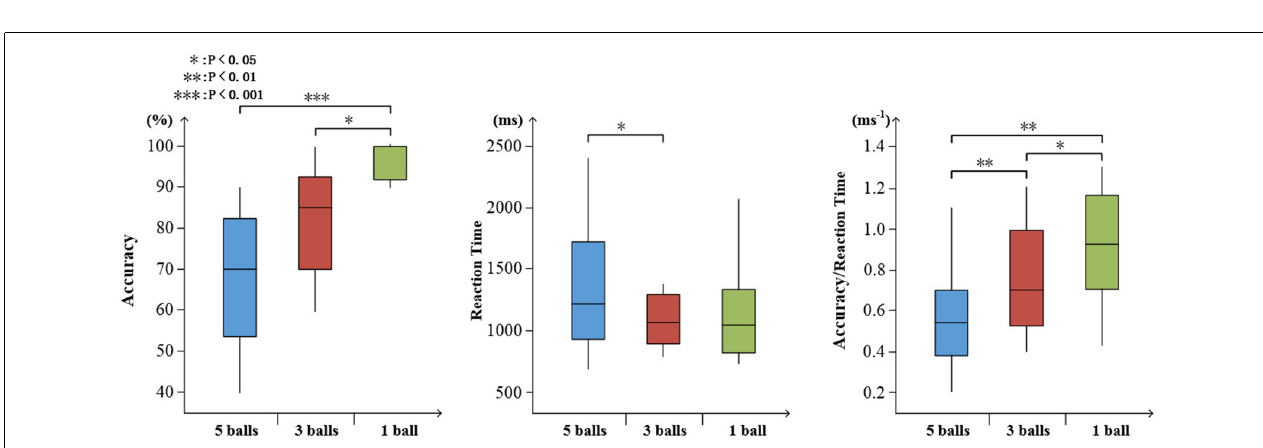
FIGURE 6 | The minimum amplitude and latency of the grand averaged sMMN for the index and little fingers. The sMMN-min compares the differences between task conditions and control conditions. The sMMN latency compares differences between task conditions and the latency trend of all participants are shown (* p < 0.05; *** p < 0.001).